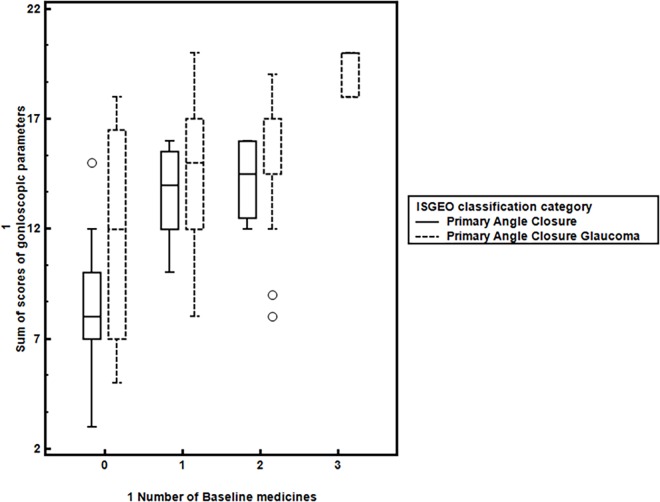
Comparison of sum of gonioscopic scores (ACSSg) with number of baseline medicines required in eyes with primary angle closure (PAC) and primary angle closure glaucoma (PACG)-circles represent outliers.